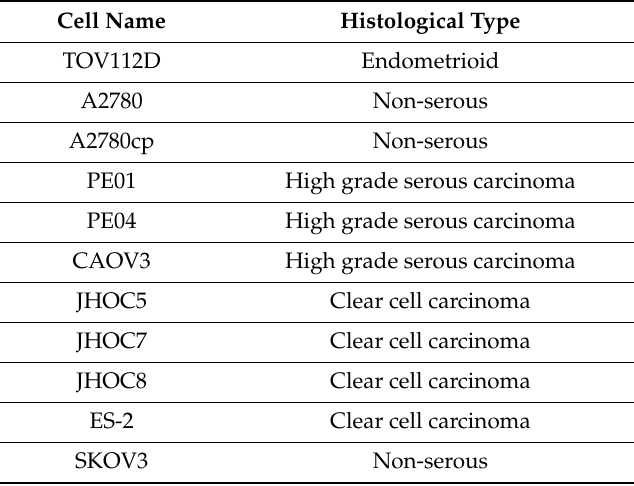
Table 1. Histological type of 11 ovarian cancer cell